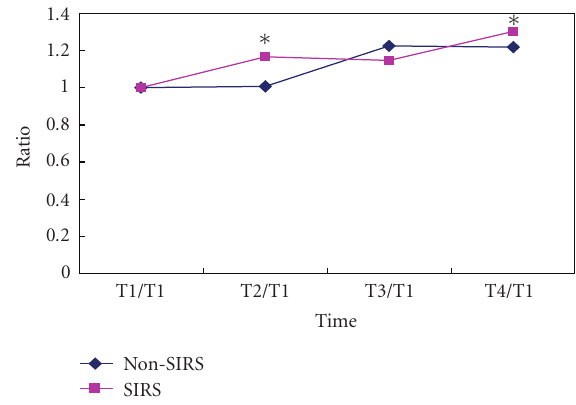
Figure 5: Increase of serum TNF- α . Median (Q) n = 12 for SIRS; ( n = 15 for non-SIRS); ∗ P < . 05, compared with